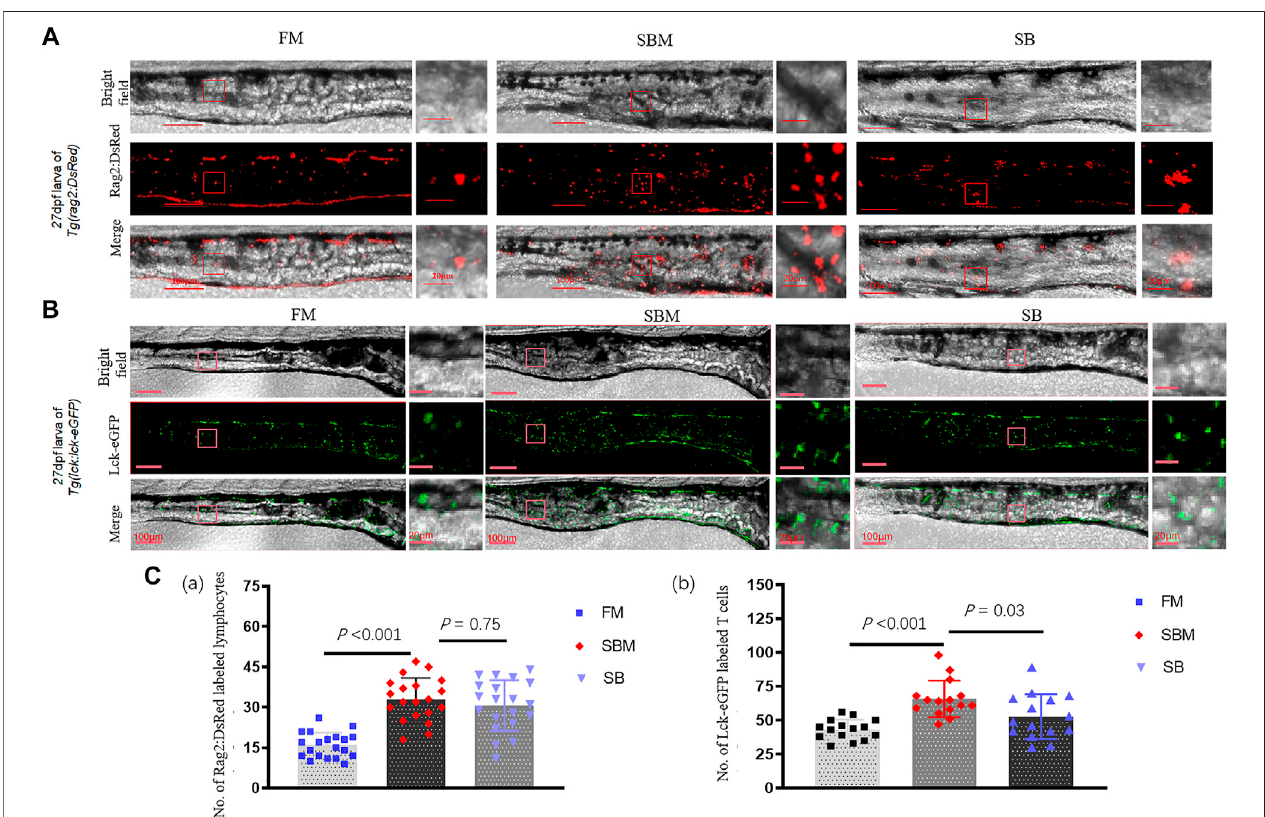
FIGURE 7 | Imaging of lymphocytes and expressional analysis of immune-related genes in SBMIE larvae model. (A) rag2:DsRed labeled immature lymphocytes imaging in 27 dpf Tg(rag2:DsRed) larvae ’ s intestine (posterior part, n = 10); (B) lck-eGFP labeled mature T cells imaging in 27 dpf Tg(lck:lck-eGFP) larvae ’ s intestine (posterior part). The square indicated the zoomed in region. The scale bar in whole pictures was 100 μ m, while the scale bar in the enlarged view was 20 μ m. (C) quantitative analysis of the signals using bar-diagrams. (a) Number of Rag2:DsRed labeled lymphocytes in larvae from either FM, SBM, or SB groups; (b) Number of Lck-eGFP labeled T cells in larvae from either FM, SBM, or SB groups. The signi fi cant differences ( p < 0.05) of Lck + T cells between SB and SBM groups were indicated by the p- value.